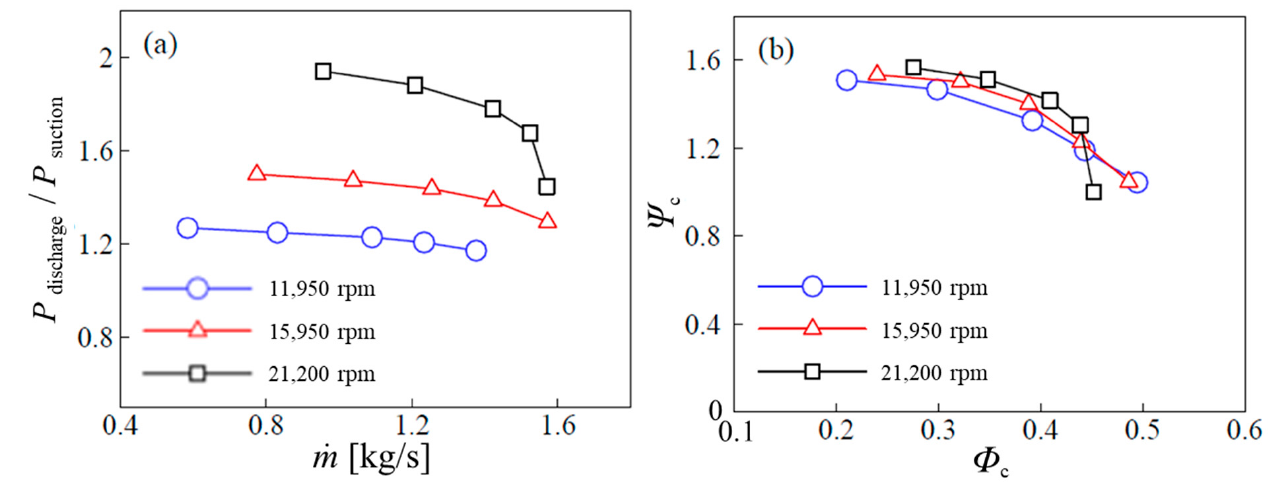
Figure 5. Compressor performance: ( a ) dimensional and ( b ) non-dimensional.